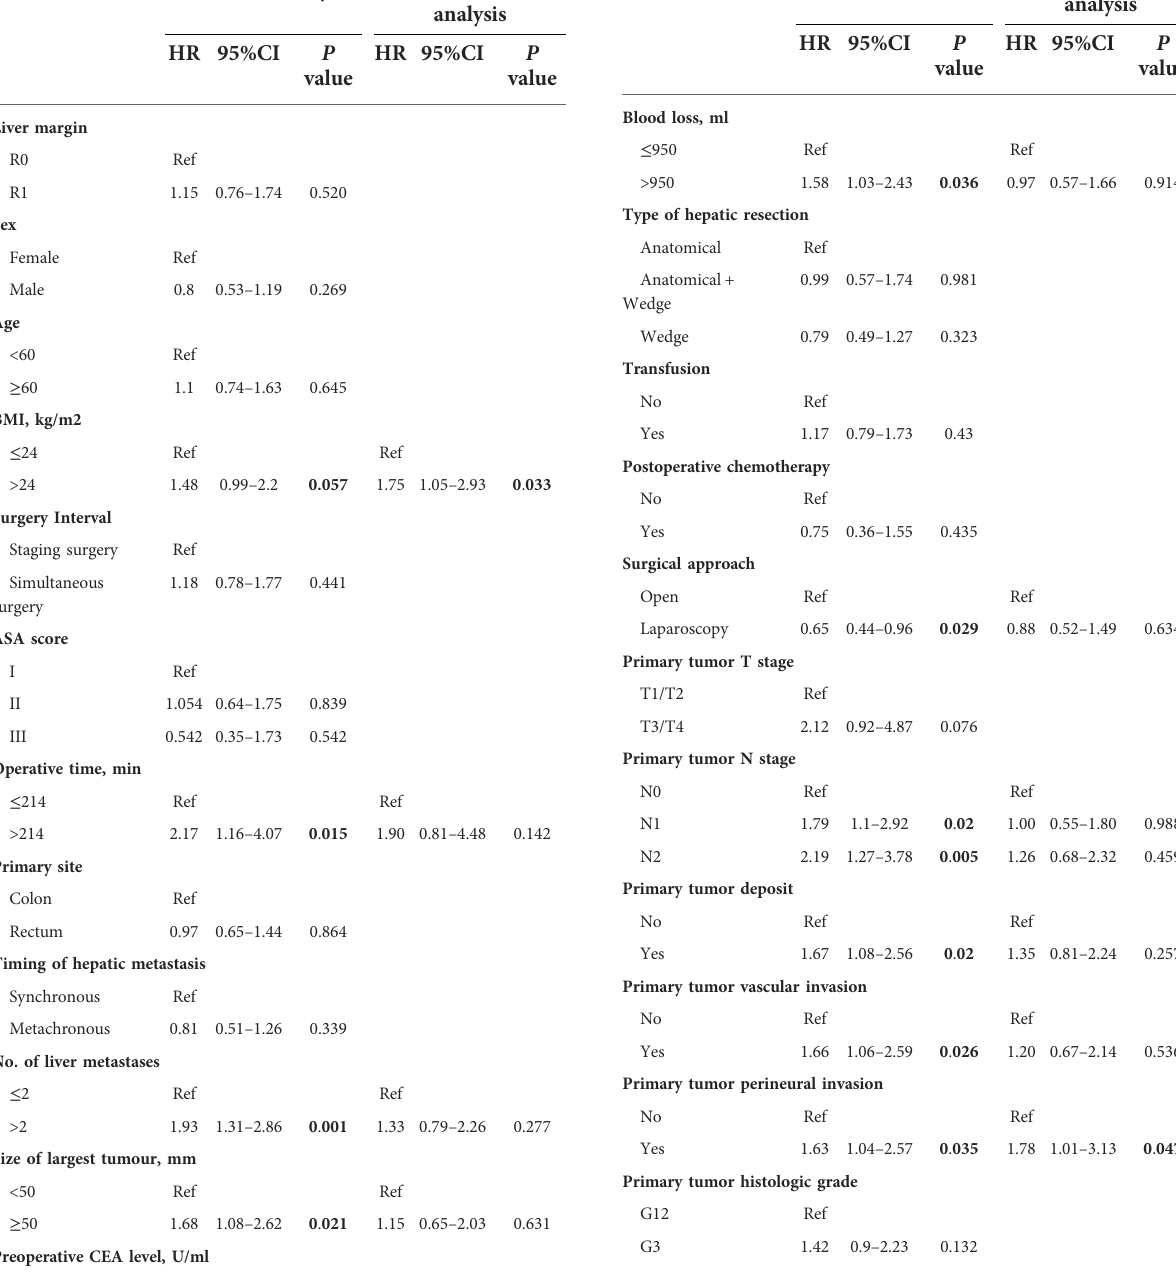
TABLE 2 Univariate and multivariable analysis of various clinical factors affecting the overall survival of the entire cohort. Univariate analysis